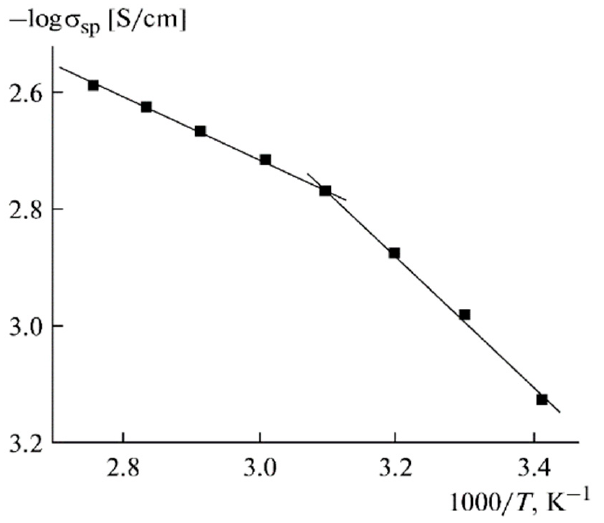
Figure 13. Temperature dependence of the specific ionic conductivity for PGE no. 9 [53].